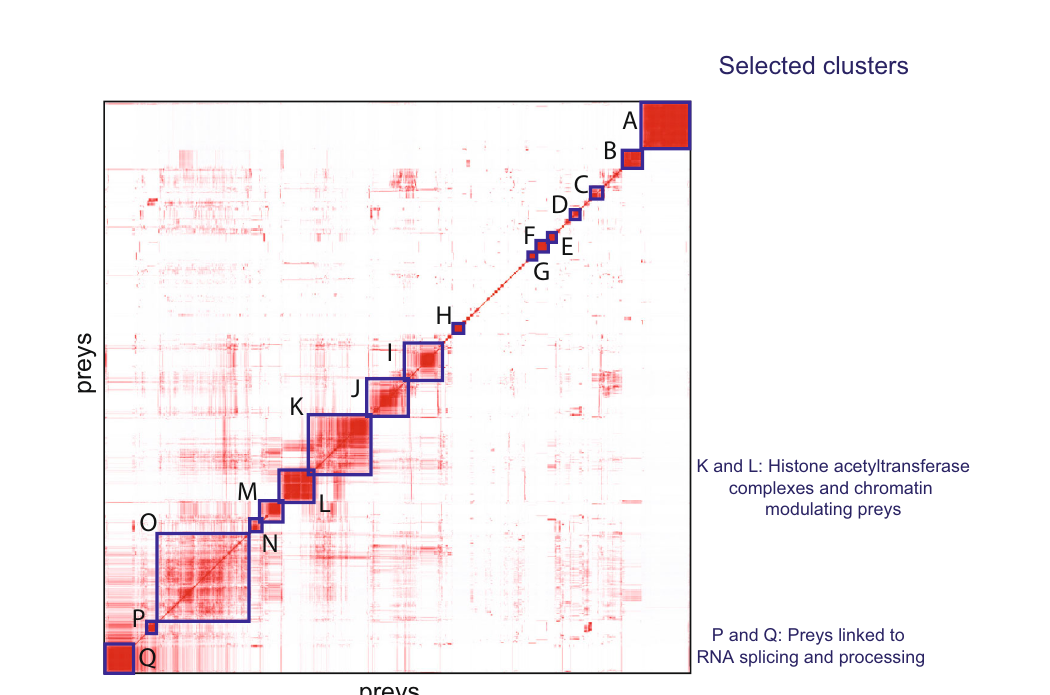
Fig. 5 Biological clusters from prey-prey correlation analysis. Prey-prey correlation analysis (ProHits-viz.) of prey identi fi ed in the BioID experiments. The results are shown in the heatmap with prey on both the x- and y-axes. Prey in clusters (A-Q) and baits driving the clusters are shown in Supplementary Data 6. The color scale indicates the Pearson correlation of prey PSMs that was performed by Prohits-viz. prior to hierarchical clustering. Source data of the fi gure are provided as a Source Data fi